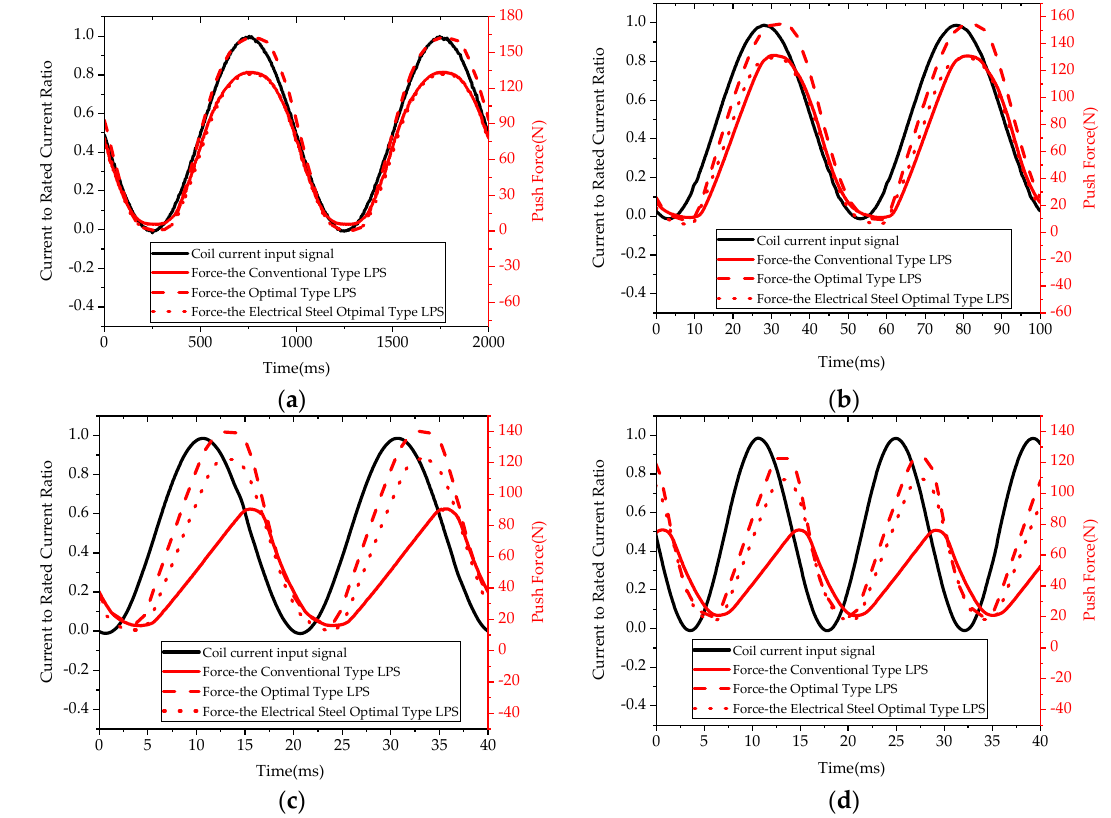
Figure 16. Force–response comparison of the three types LPS. ( a ) 1-Hz-current input signal; ( b ) 20 Hz current input signal; ( c ) 50-Hz-current input signal; ( d ) 70-Hz-current input signal.